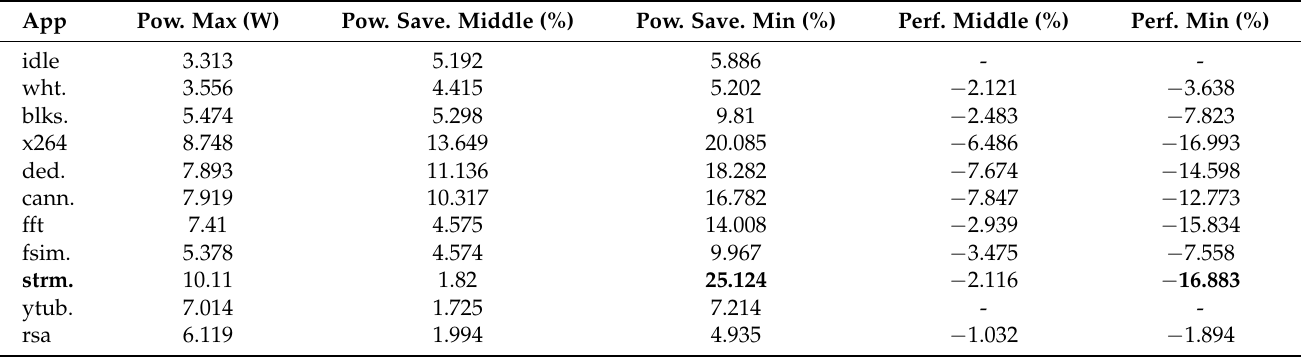
Table 2. Power consumption (Pow. max) of different benchmark applications (App) when executing the application on the maximum operating frequency of the memory. Pow. save middle (%) and Pow. save min (%) are the improvements in power savings when executing the application on the middle operating frequency and minimum operating frequency, respectively. Perf. middle (%) and Perf. min (%) indicate the loss in performance for executing the application on the middle operating frequency and minimum operating frequency,